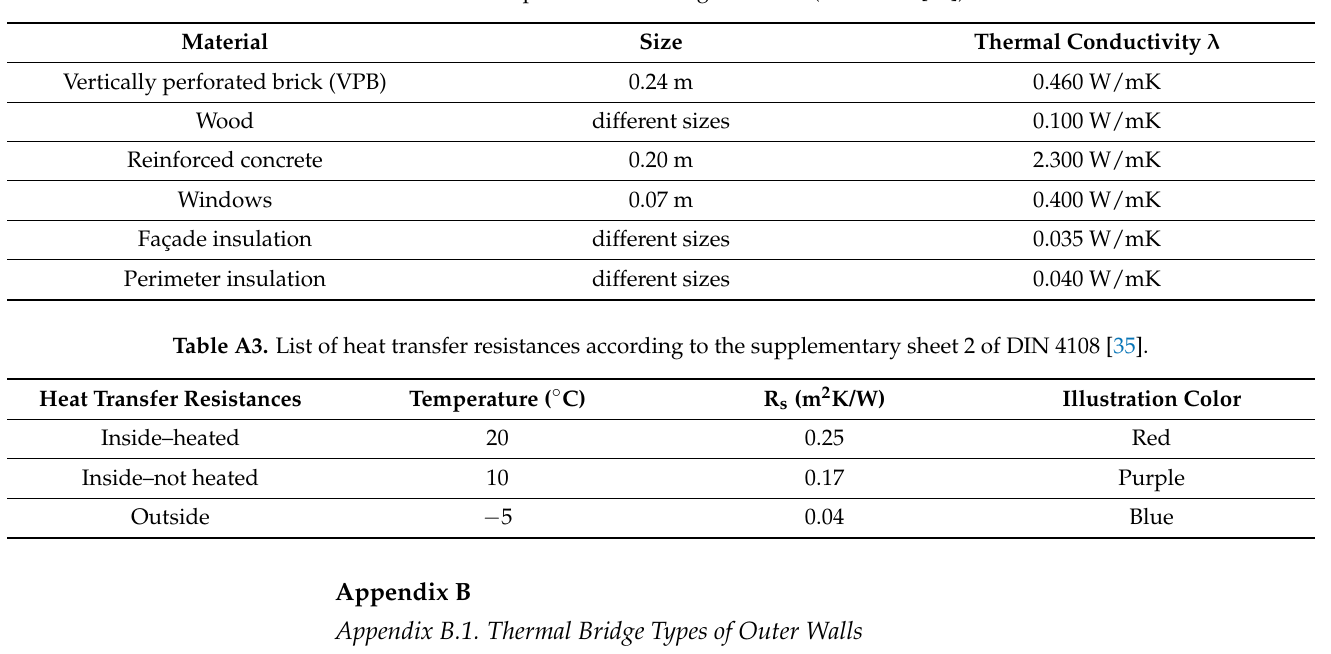
Table A2. Assumptions for building materials (based on: [50]).